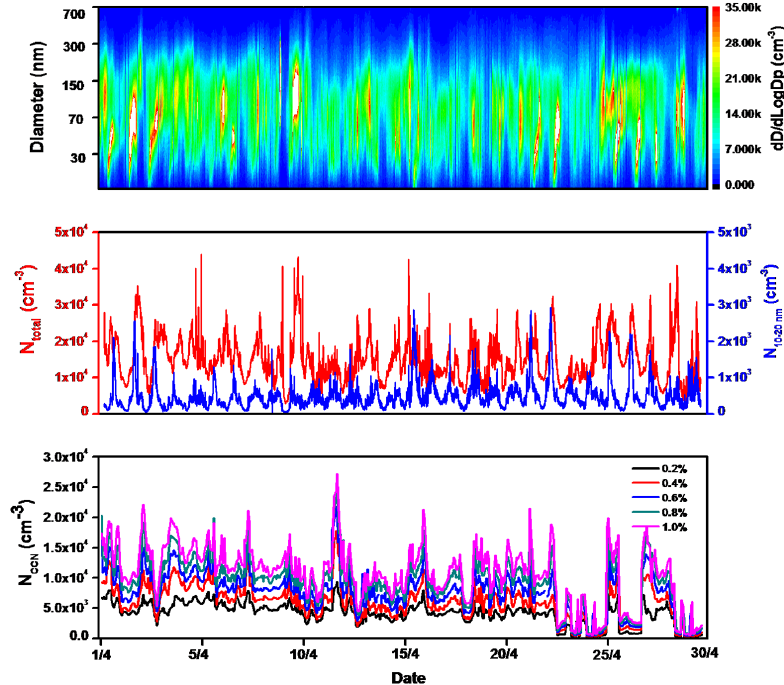
Figure 3. Series of aerosol size distribution, 4min mean total ( N total ) and nucleation-mode aerosol number concentration ( N 10–20nm ) and 1h mean CCN concentration over the entire